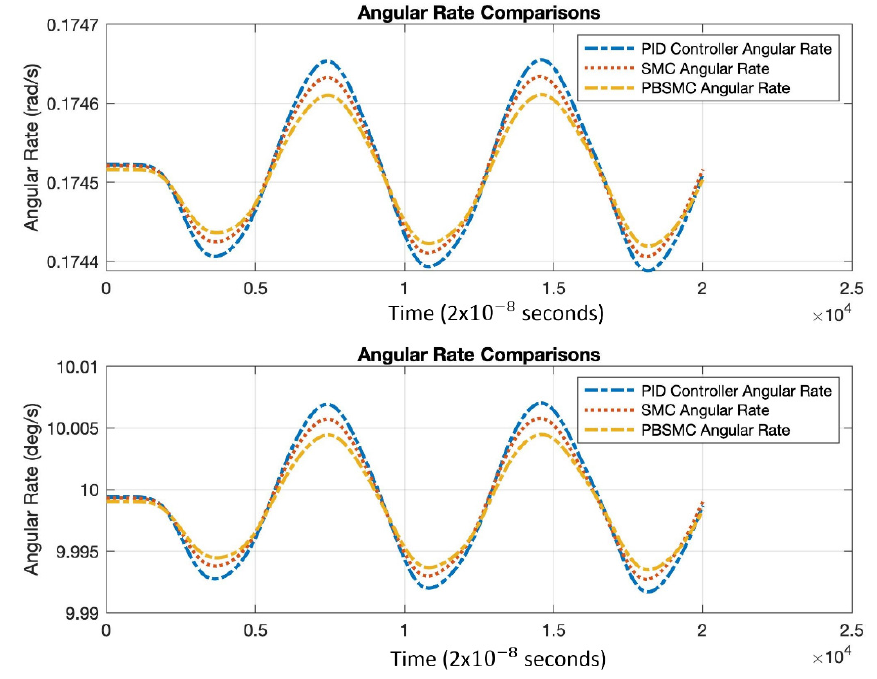
Figure 13. Angular Rate Measurement Comparison. Table 9. Error Performance and Convergence Time Comparison for Experimental Data.